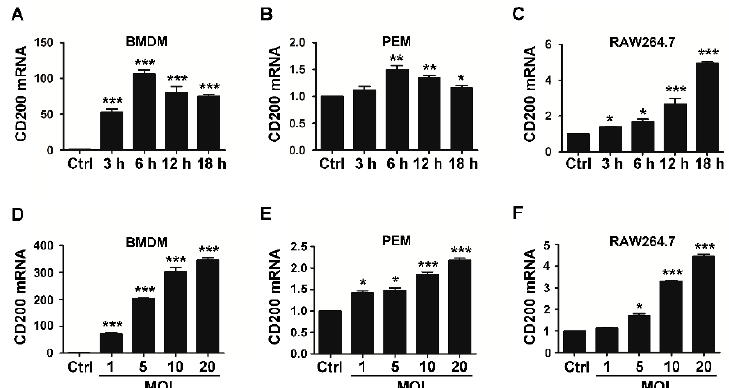
Figure 1. S. aureus infection induces CD200 expression in murine macrophages. Mouse BMDMs ( A , D ), PEMs ( B , E ), or RAW264.7 cells ( C , F ) were challenged with S. aureus (MOI = 1) for the indicated time periods (0–18 h), or with S. aureus at the indicated MOIs (0–20) for 6 h. Cells were then collected and detected for CD200 mRNA level by qPCR. Results are expressed as the mean ± SD of three independent experiments; * p < 0.05, ** p < 0.01, *** p < 0.005 versus Ctrl.